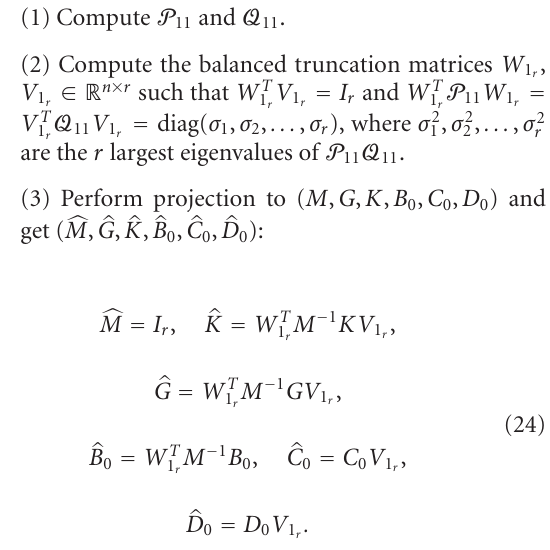
Algorithm 1 (Balanced truncation method based on P 11 and